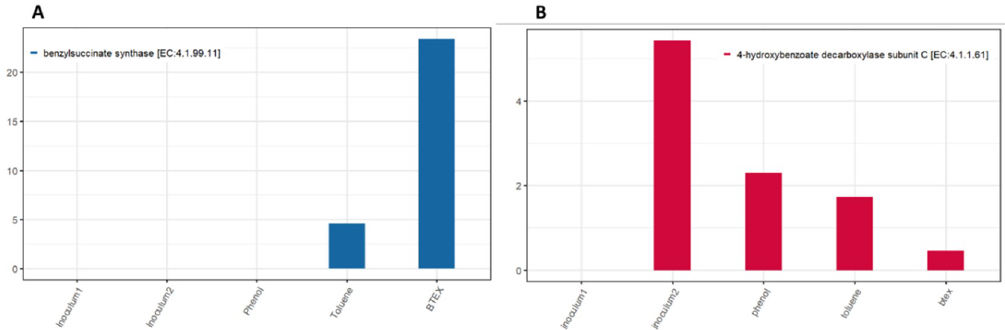
Figure 4. Coverage of ( A ) benzylsuccinate synthase [EC:4.1.99.11] and ( B ) 4-hydroxybenzoate decarboxylase [EC:4.1.1.61] based on normalized abundances of CDS classified with KEGG.